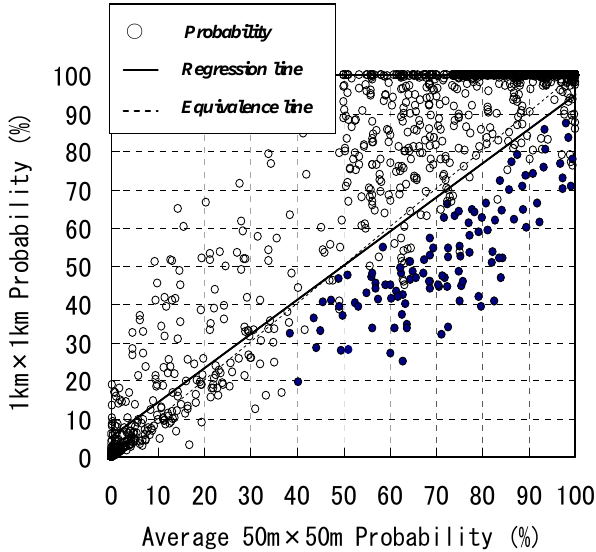
Fig. 13. Relationship between landform class and average probability for extreme precipitation in 100 years return period for coarse and fine resolution maps in Niigata Prefecture